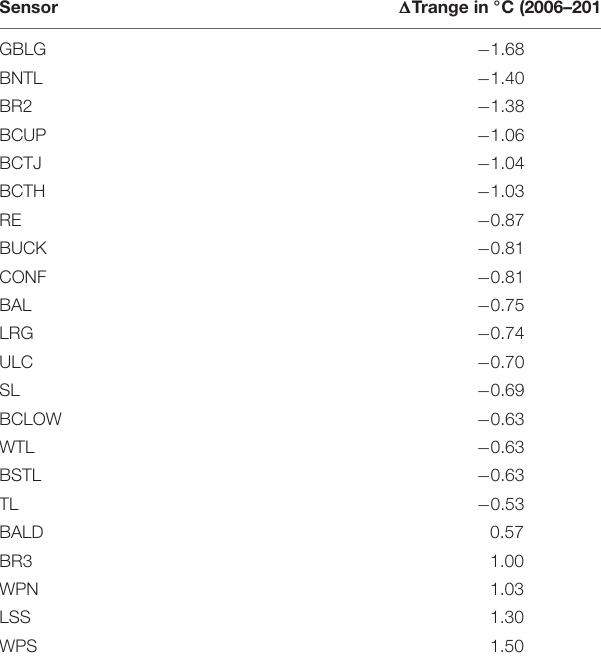
TABLE 3 | Significant changes in T range for the ESN sensors, including daily T range from